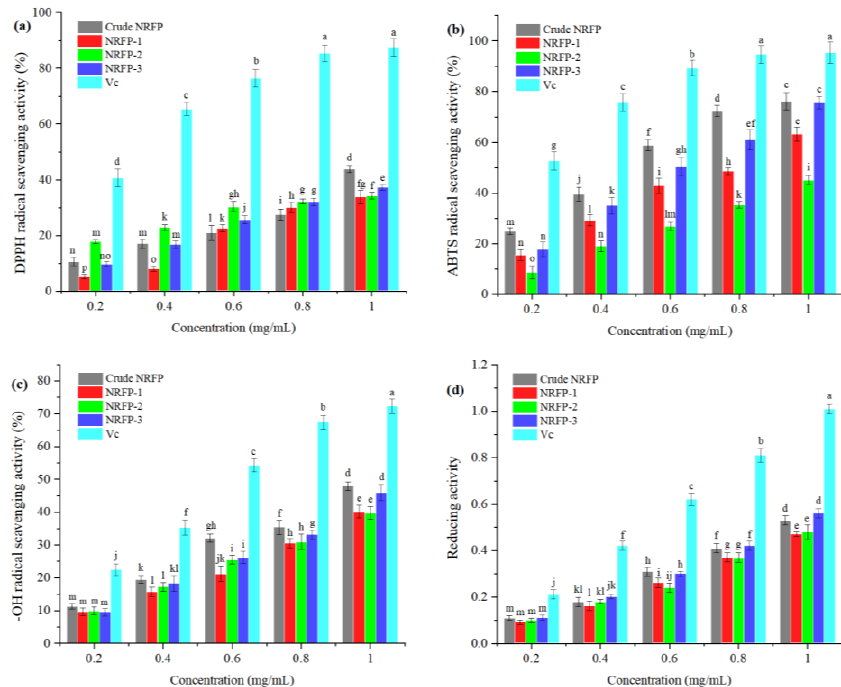
Figure 6. The antioxidant activities of NRFPs. ( a ) DPPH radical scavenging activity; ( b ) ABTS radical scavenging activity; ( c ) -OH radical scavenging activity; ( d ) reducing activity.